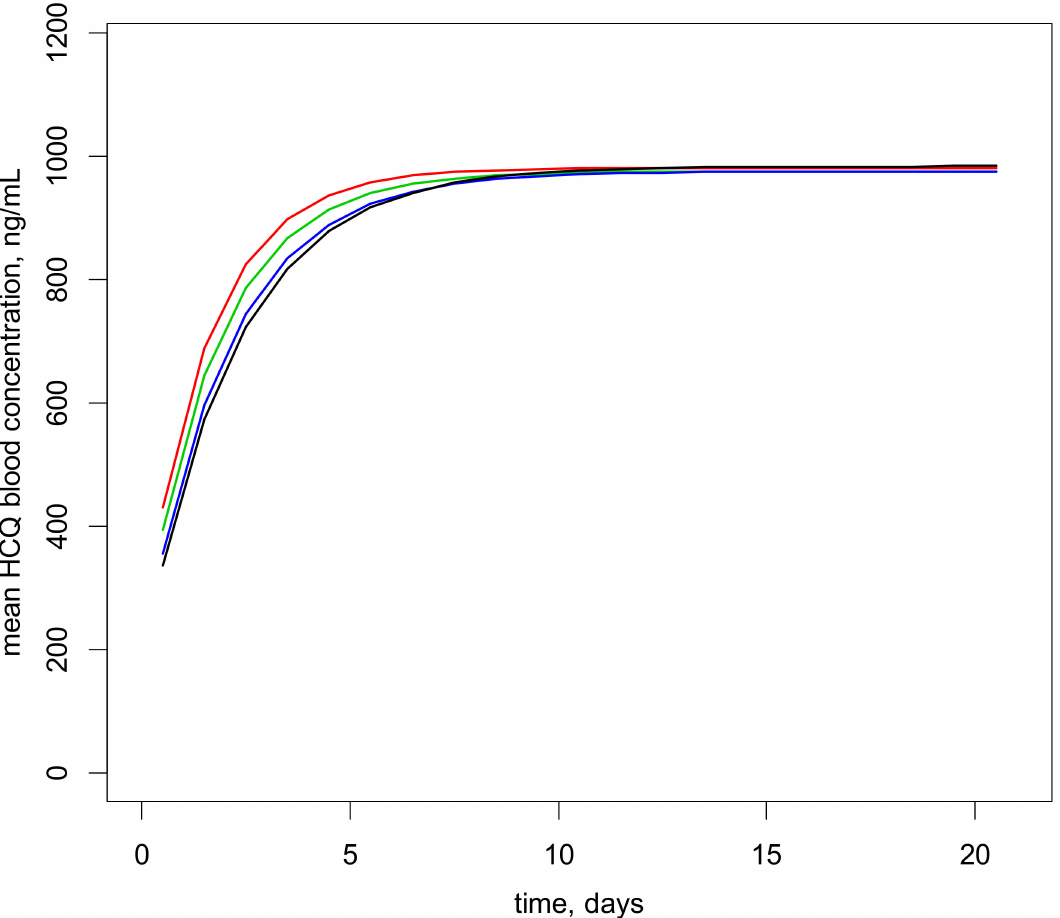
Figure 4. Mean blood HCQ concentration–time courses obtained using the dosing schedule from Table 3. Patient body- weights are set to the mean of each weight band, 18 (red), 28 (green), 47.5 (blue), and 66 (black) kg. The curves connect the mean concentrations computed at each dose